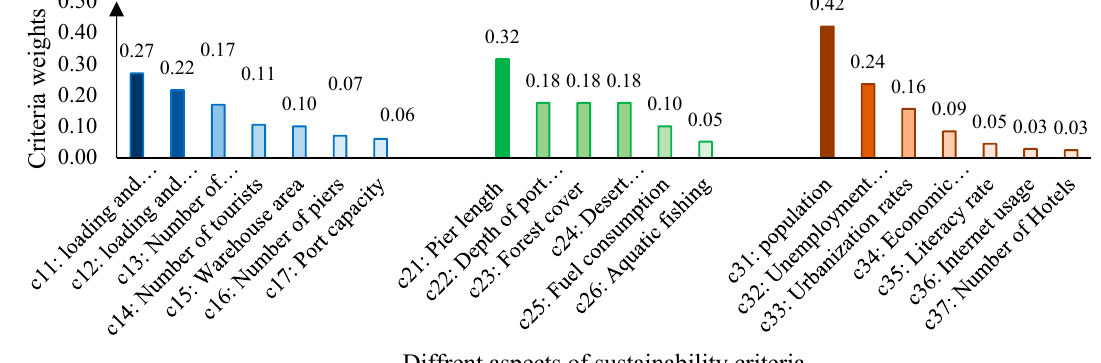
Figure 2. Weight of each sub-criteria for all aspects of sustainability.